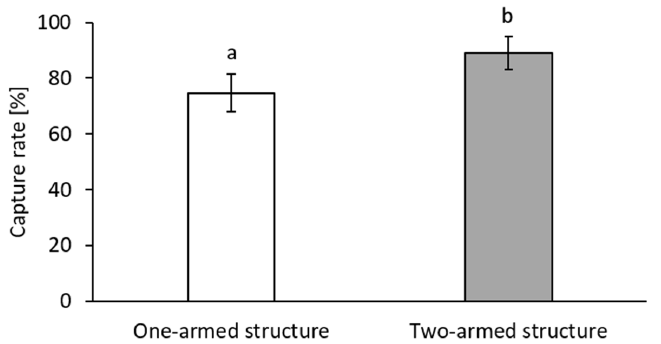
Figure 5. Capture rates of BT-474 cells spiked into 200 µ L of blood and drawn through the TEM-grids integrated into the different filter holder slides. The capture rate was significantly increased by the filter holder design with the divided inlet and outlet channels. Results are given as means ± SD. Different letters above the bars (a and b) indicate statistical difference ( n = 3; p < 0.05).